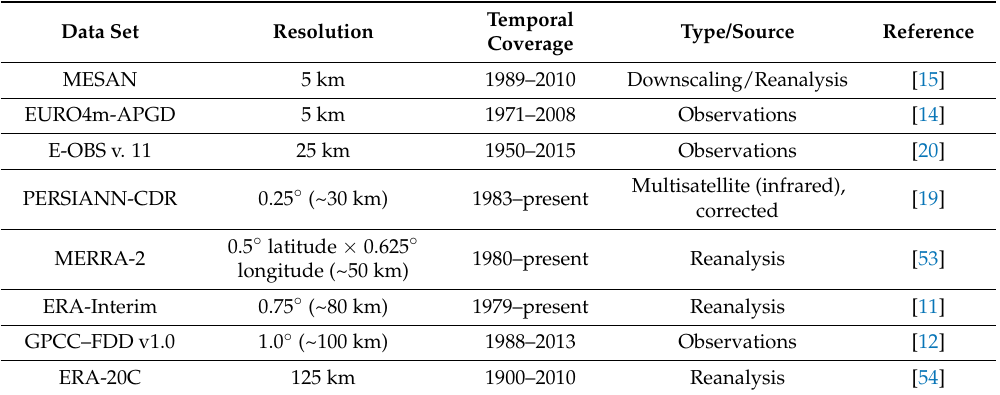
Table 1. Overview of data sets included in this study with corresponding spatial resolution, temporal coverage, data set type or source respectively, and reference